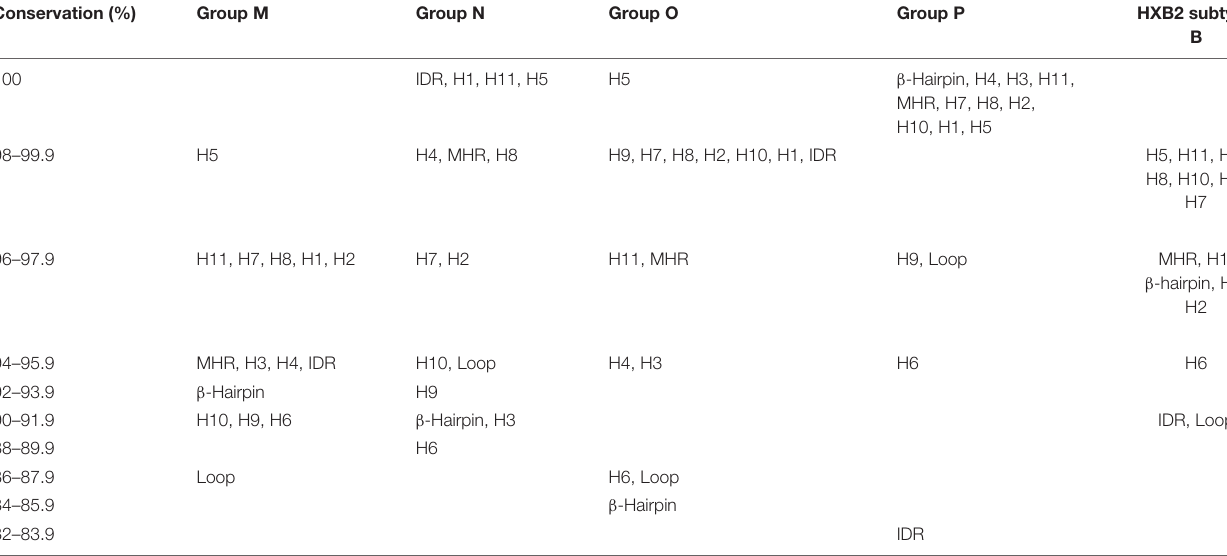
TABLE 3 | Range of conservation of each element of p24 secondary structure in the four HIV-1 groups and group M subtype B consensus. Conservation (%) Group M Group N Group O